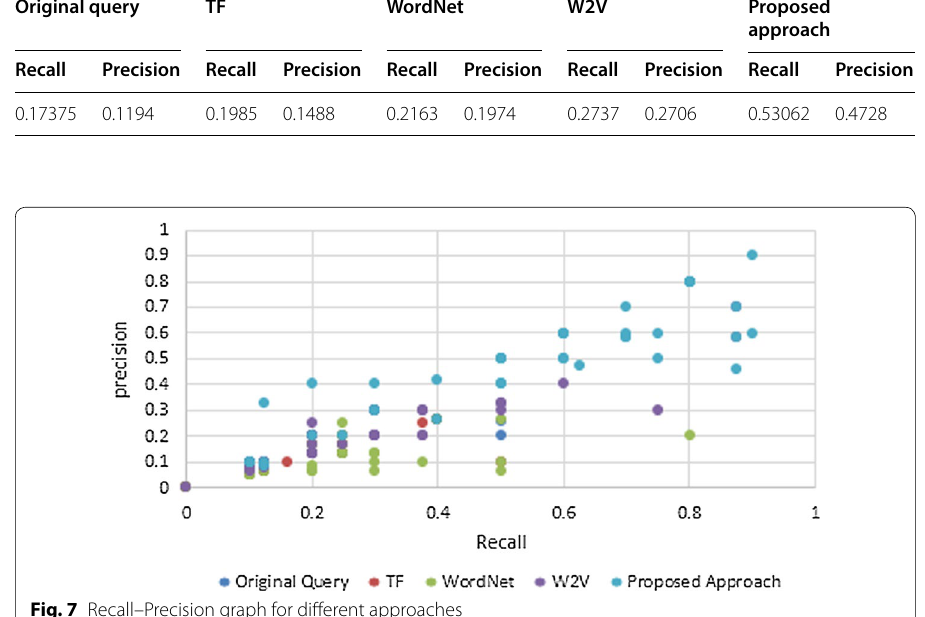
Fig. 7 Recall–Precision graph for different approaches